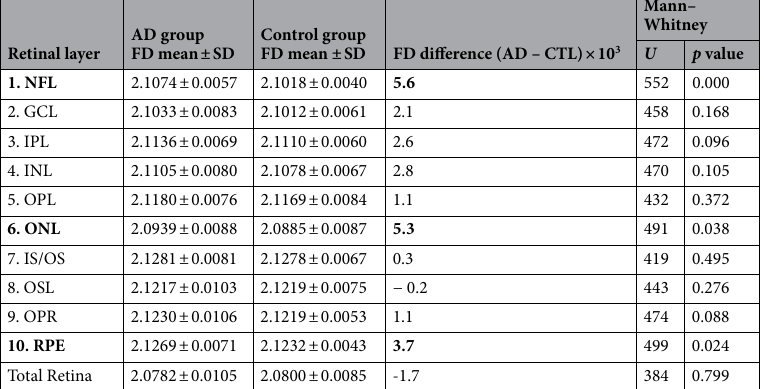
Table 2. Fractal dimension of the thickness maps of retinal layers in Alzheimer disease patients and control groups. Statistically significant differences (p < 0.05) and the corresponding layer names appear in boldface. AD Alzheimer’s disease, FD fractal dimension, SD standard deviation, CTL control (group), NFL nerve fiber layer, GCL ganglion cell layer, IPL inner plexiform layer, INL inner nuclear layer, OPL outer plexiform layer, ONL outer nuclear layer, IS/OS inner segment/outer segment layer, OSL outer segment layer, OPR outer segment PR/RPE complex, RPE retinal pigment epithelium.